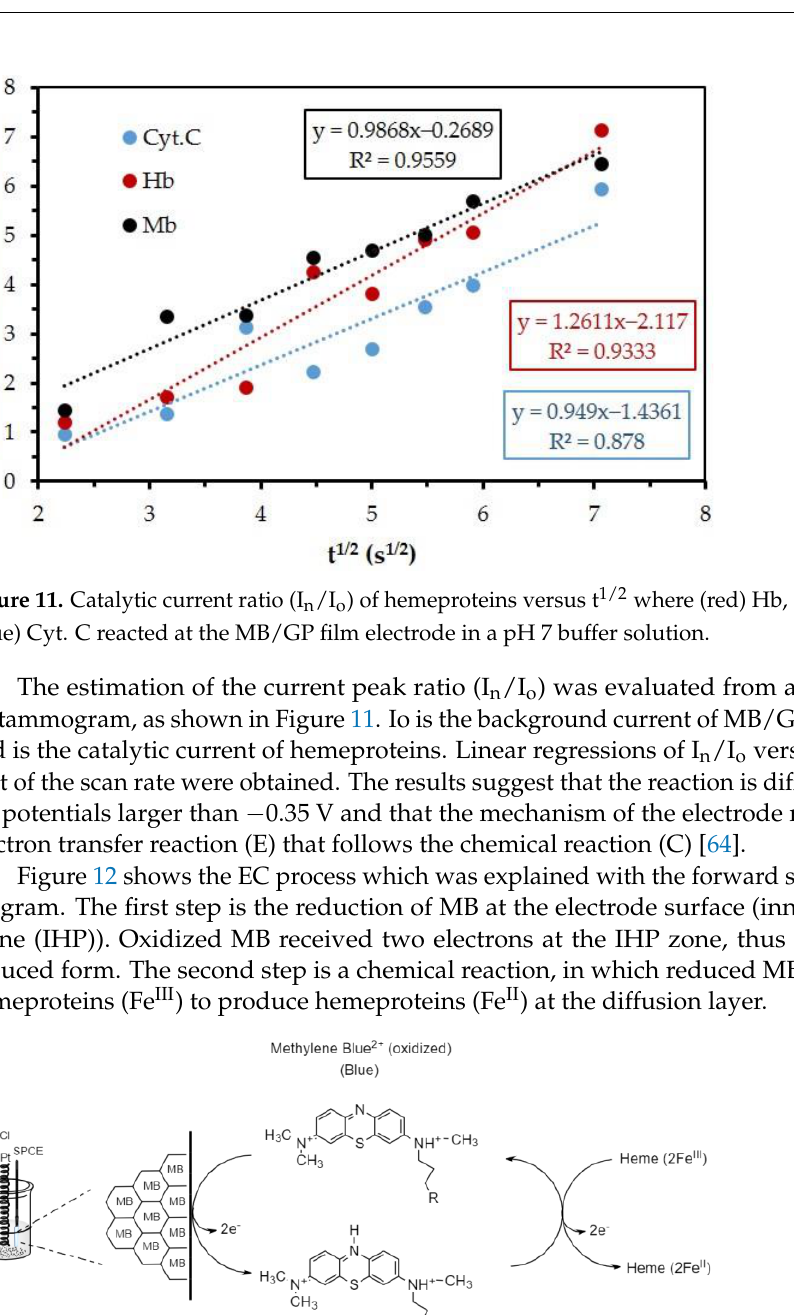
Figure 12. Electrocatalytic reduction of hemeproteins at MB / GP modified electrode .